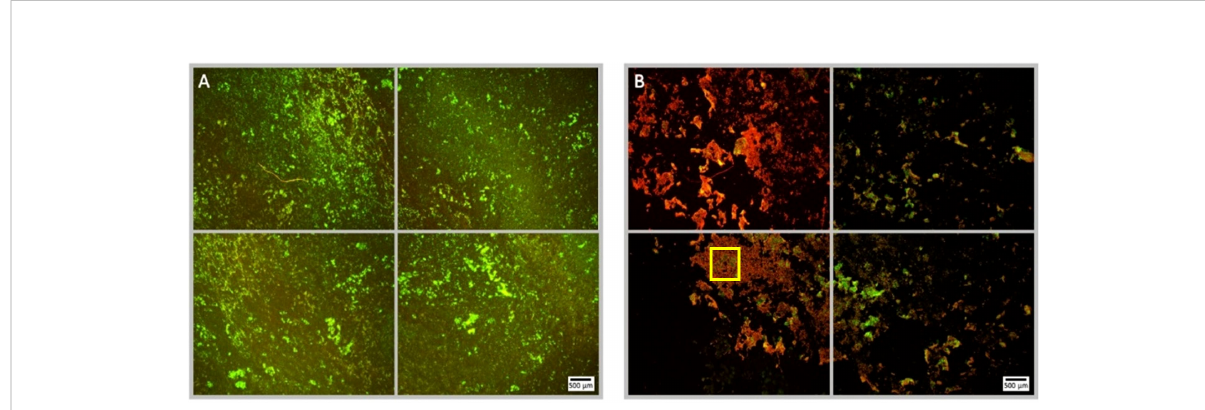
FIGURE 5 Fluorescence microscopy images of P. aeruginosa bio fi lm treated with NOMB + without antibiotic, stained with Syto9 (green) and PI (red). Panel (A) images depict the pre-treatment morphology of the bio fi lm over a 1 cm 2 area. Panel (B) images show the changes in morphology after ultrasound stimulation of NOMB + without antibiotic; 45 Vpp was applied to the transducer to reach an acoustic pressure of 0.5 MPa at the target site for 40 s, with a driving frequency of 0.9 MHz, duty cycle of 20% and a 500 Hz PRF. It is demonstrated in Panel (B) that though there is a higher proportion of biomass still attached to the surface, the majority of this appears to consist of PI-stained dead cells. A yellow box has been added in the lower left image of panel (B) , to indicate the location at which Supplementary Figure 4 was viewed at 20x magni fi cation.